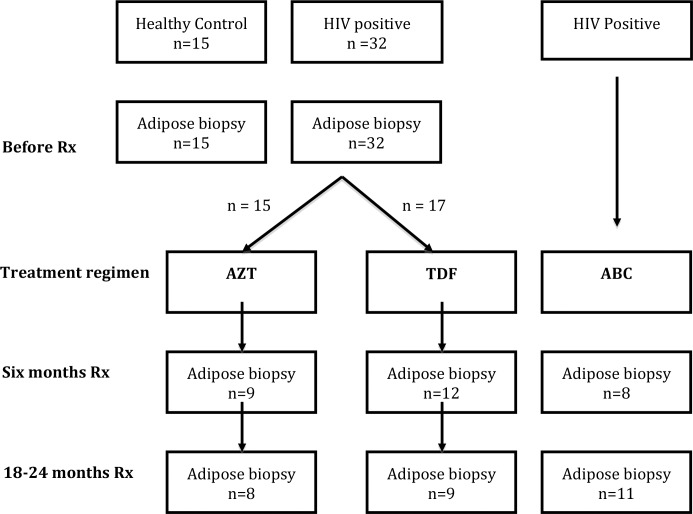
Flow chart of study design. Rx = treatment; AZT = zidovdine and lamivudine; TDF = tenofovir and emtricitabine; ABC = abacavir and lamivudine.All three groups were also taking efavirenz; n = number of samples available for microarray at each time point.